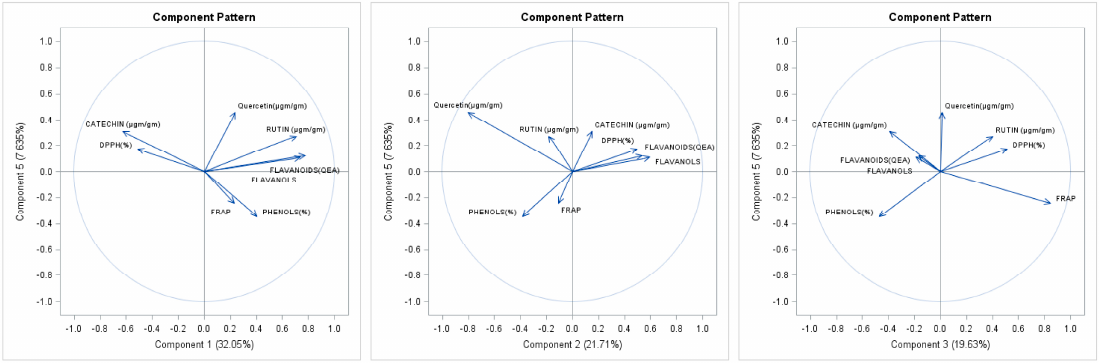
Figure 1. Principal component analysis showing the variability in phenolics and varied antioxidant assays among different apple varieties.